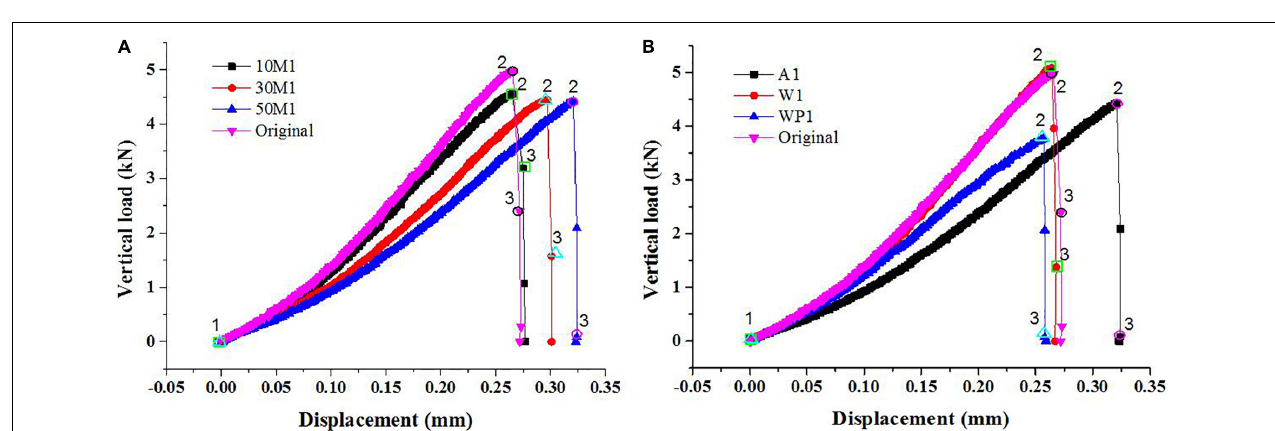
FIGURE 4 | Comparison of load-displacement curves of gritstone specimens under the two types of treatment conditions: (A) hydro-thermal treatment; (B) cool down treatment.